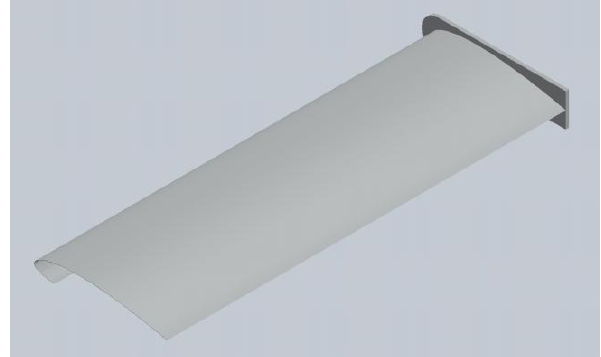
Figure 1. A J-blade used on vertical axis wind turbines (VAWTs).